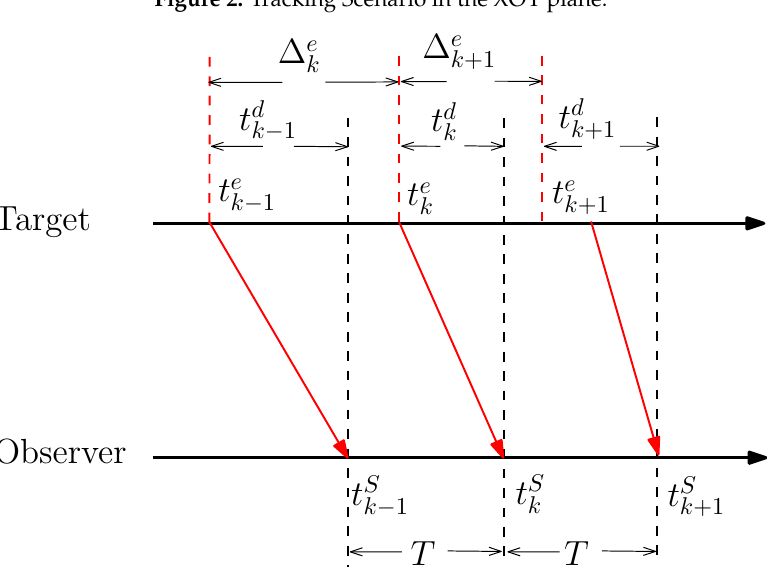
Figure 2. Tracking Scenario in the XOY plane.